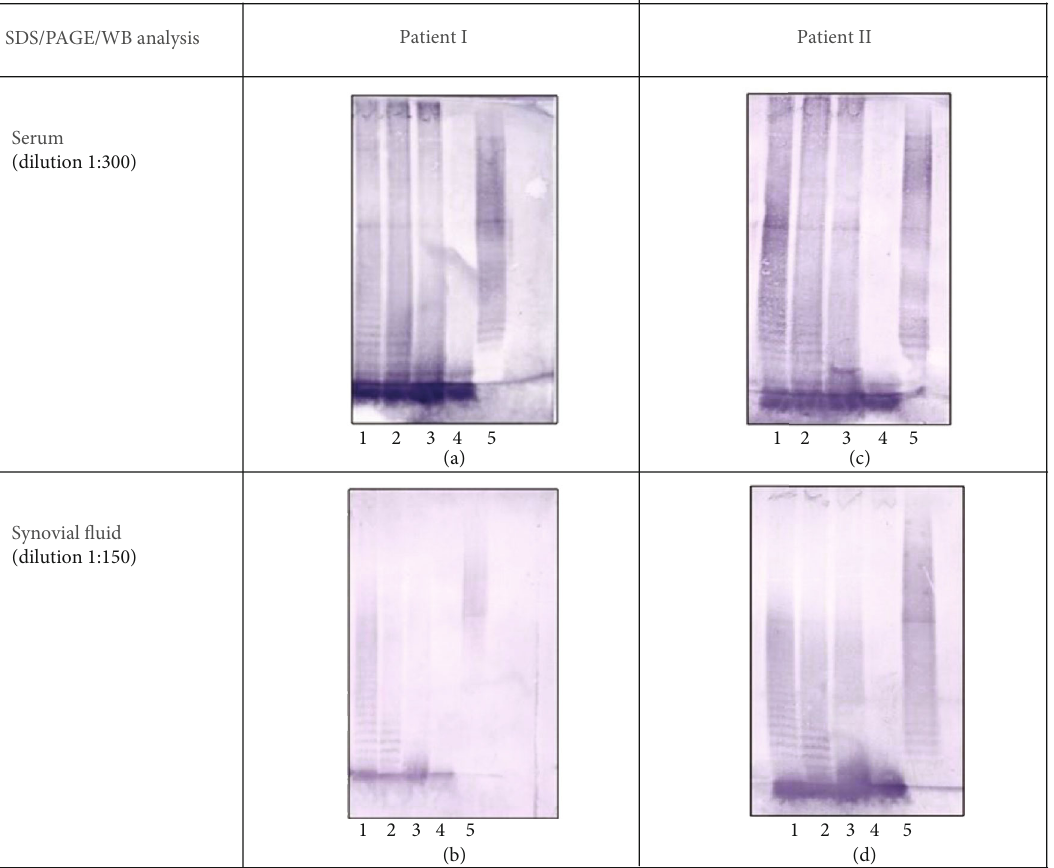
Figure 1: Detection of Yersinia LPS- and ECA- reactive antibodies in sera and synovial fl uids from patients I and II. Wild (S) type, Ra, Rc and Re chemotype LPS and ECA preparations were separated in SDS-PAGE. After transfer to PVDF, the membranes were incubated with synovial fl uid or corresponding patient serum. Lanes 1-YeO3-c (wild-type) LPS, 2-YeO3-c-R1 (Ra) LPS, 3-YeO3-c-Rfb-R7 (Rc) LPS, 4- YeO3-c-M205LPS (Re) LPS, and 5- S. Montevideo SH94